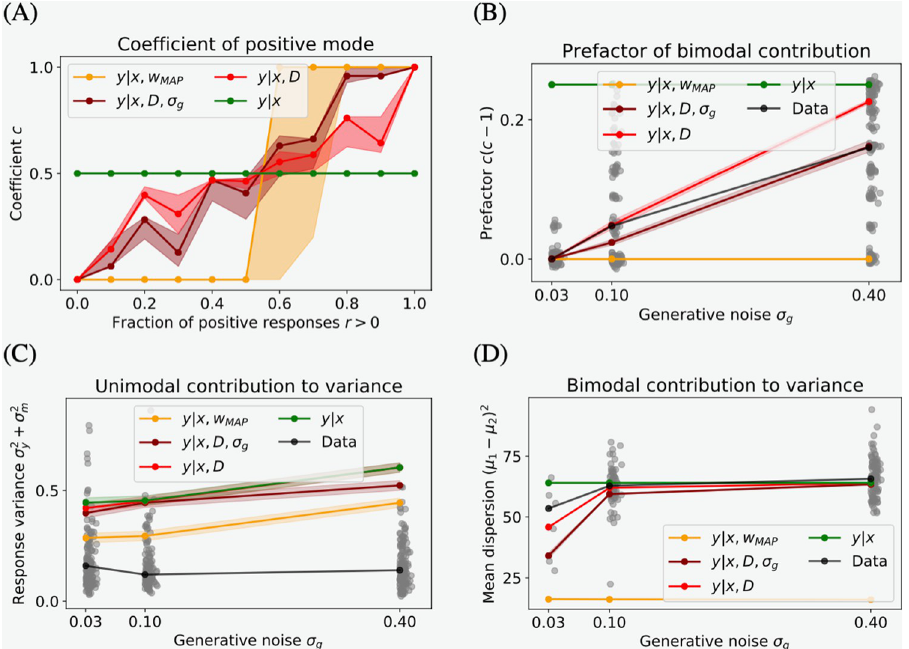
Fig 5. Median of each of the bimodal response distribution variance components across all participants and stimuli. (A) Predicted coefficient of positive mode as a function of the empirical coefficient (across all noise levels). ML-R behaves identically to MAP-R. Thus, the MAP-R curve represents both models. The shaded area shows the 40% and 60% quantiles. (B) Prefactor of bimodal contribution as a function of generative noise. Data jittered for visibility. (C) Unimodal contribution to the variance. Empirical variance computed on mode with majority of responses. (D) Mean dispersion. Only trials with bimodal responses included. As the stimulus becomes more noisy, human responses and B-R variants conform to the